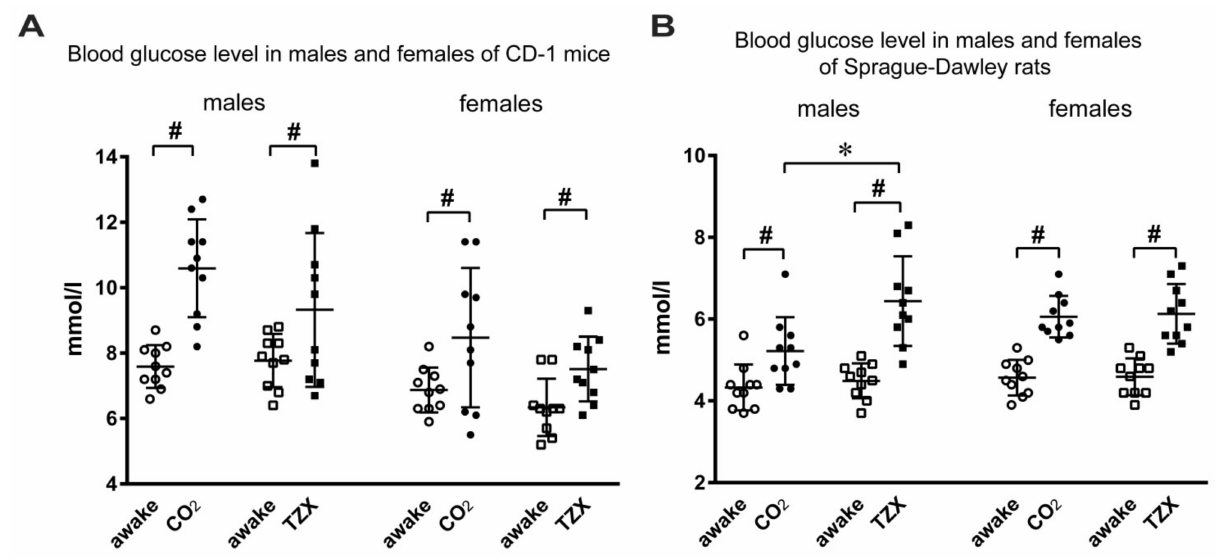
Figure 1. Blood glucose levels in males and females of CD-1 mice ( A ), and Sprague Dawley rats ( B ), in the awake state and following 5 min after CO 2 inhalation or tiletamine–zolazepam–xylazine (TZX) anesthesia. # p < 0.05 TZX versus awake, * p < 0.05 TZX versus CO 2